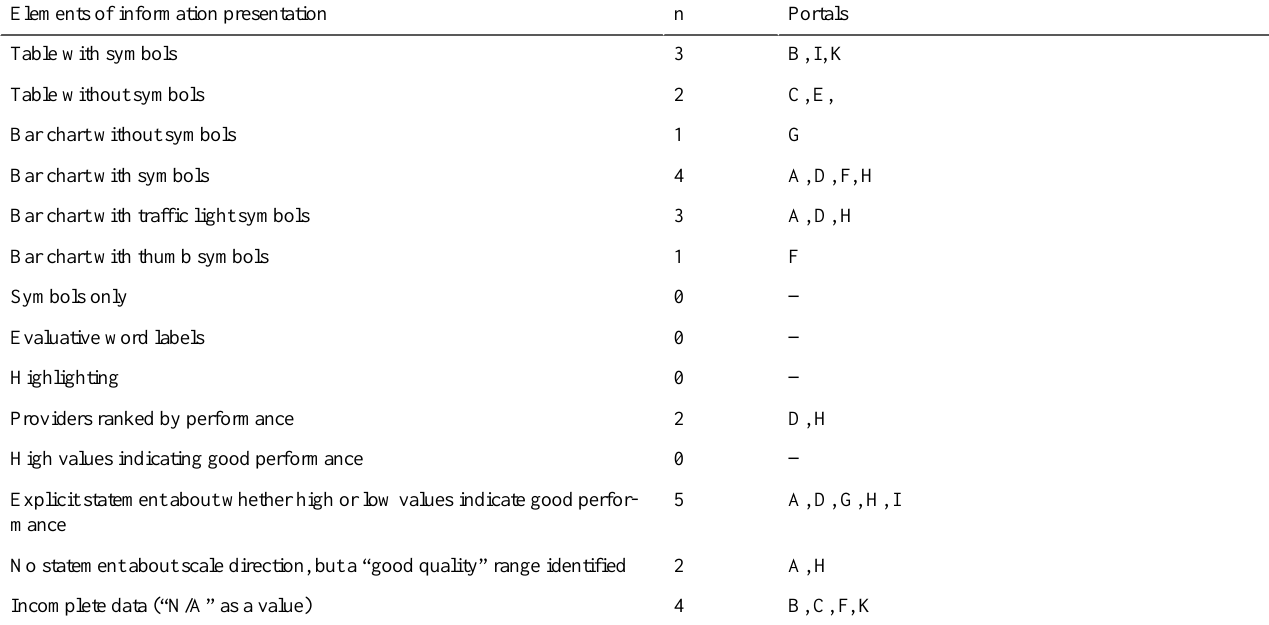
Table 2. Features used in the presentation of risk-adjusted mortality rates for coronary catheterization by 10 German portals. PortalsnElements of information presentation